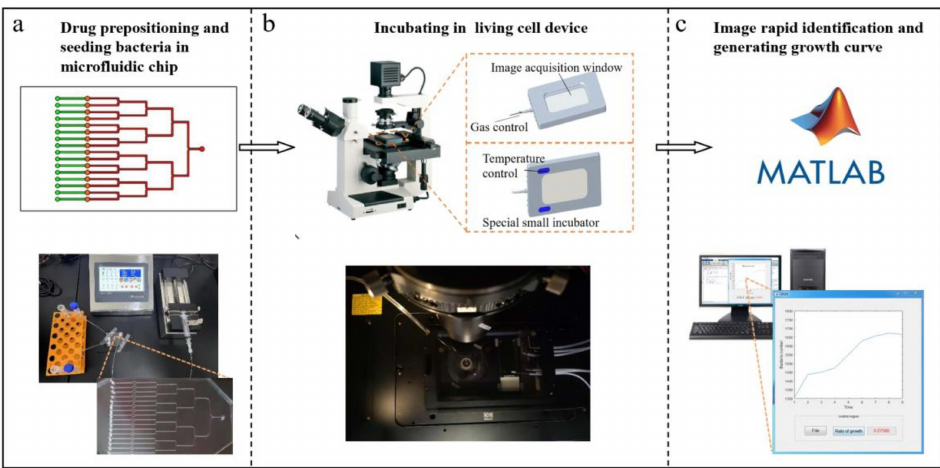
Figure 1. Process of the single-cell level rapid AST system. ( a ) Bacteria are injected into the microfluidic chip using a microflow pump. ( b ) The microfluidic chip is placed in the living cell device positioned on the microscope stage for incubation and real-time detection. ( c ) Photos captured by the microscope are processed by the Matlab software to generate the growth curve. The hardware used are also